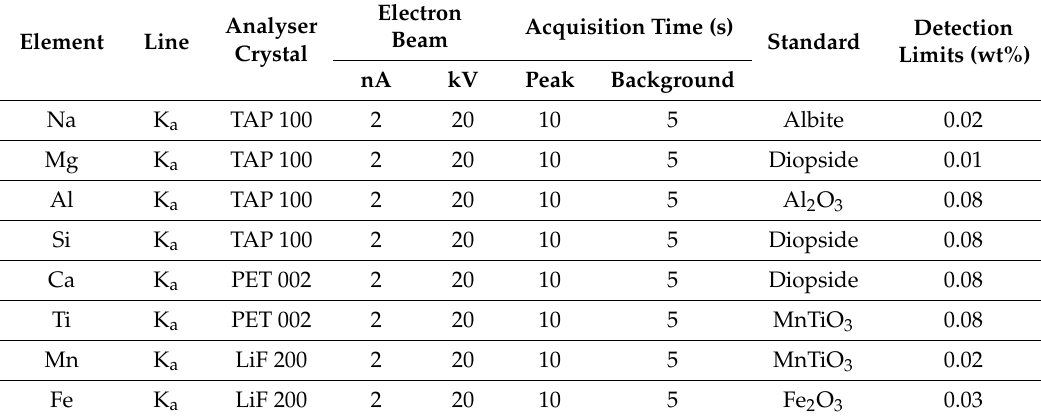
Table 2. EMPA analytical conditions for manganese-containing inclusions. Analyser crystals used: LiF (lithium fluoride with d 200 = 2.01 Å), PET (pentaerythritol with d 002 = 4.37 Å) and TAP (thallium acid phthalate with d 100 = 12.84